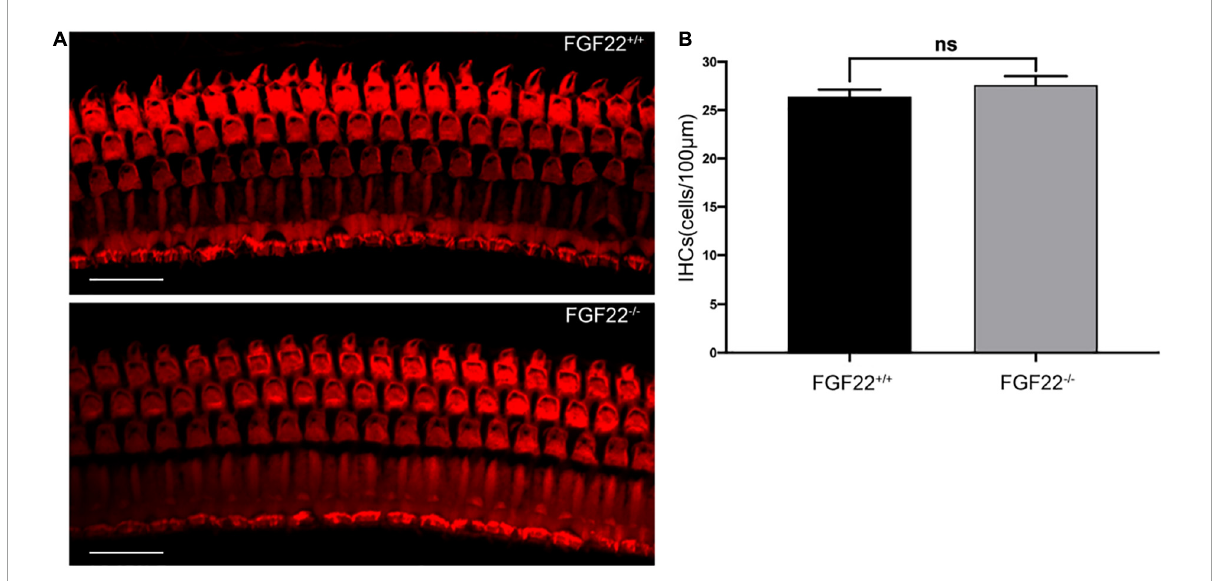
FIGURE2 Whole-mount of the cochlea hair cells in Fgf22 + / + and Fgf22 − / − groups. (A) Isolated cochlea hair cells were immunostained with phalloidin (red). Scale bars: 20 µ m. (B) The bar chart showed no difference in the hair cells between the Fgf22 + / + and Fgf22 − / − groups.